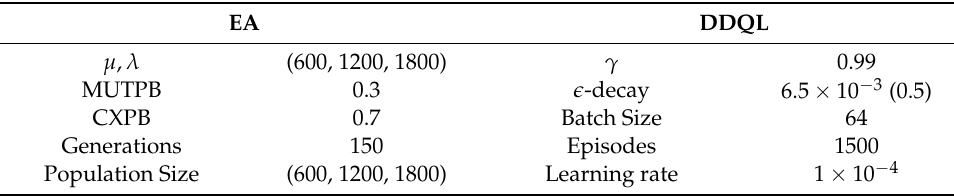
Table 7. Parameters for the multi-agent case simulations.